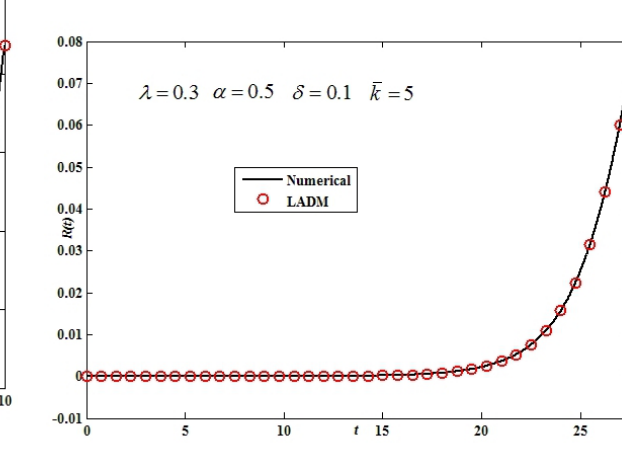
Fig. 4. Comparison of the LADM solutions of R(t) with numerical method.